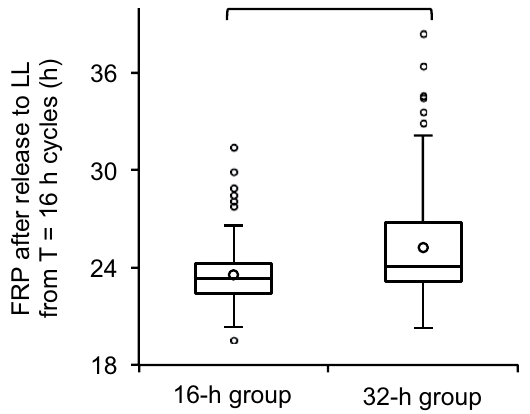
Figure 4. Comparison of fundamental periods under T = 16 h cycles and FRPs under LL. Bioluminescence traces of the AtCCA1::LUC reporter were obtained by the single-cell bioluminescence monitoring under T = 16 h cycles, and then were released into LL. See Supplementary Fig. 9 for details of the release experiment. Individual traces with fundamental periods of shorter than 20 h and longer than 25 h were categorised into the 16-h group ( n = 115) and the 32-h group ( n = 81), respectively. Boxplots show FRPs of bioluminescence traces with RAE values less than 0.4 for the two groups. Three horizontal lines in each box represent 75%, median and 25% from the top to the bottom. A circle in each box represents the mean value. The bar ends represent the lowest datum still within 1.5 × interquartile range of the lower quartile, and the highest datum still within 1.5 × interquartile range of the upper quartile. Circles outside of the boxes represent outliers of 1.5 × interquartile range. Three experiments were conducted. * p < 0.01, the significant difference between the mean values is based on a two-level nested ANOVA model with two groups (16-h or 32-h group), and subgroups (individual plants in the three experiments) nested within the